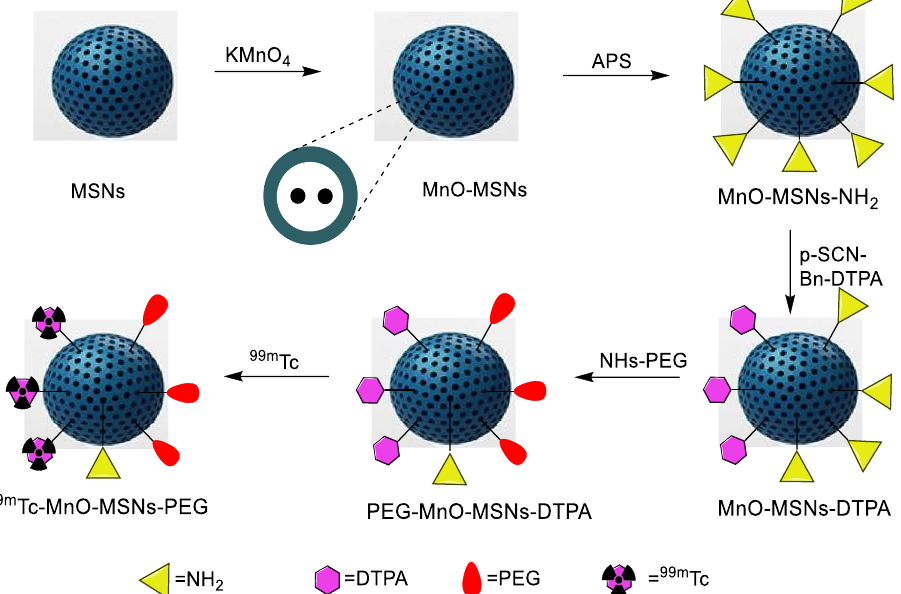
Figure 9. Synthesis of multifunctional mesoporous silica nanoparticles (SBA-15). Step 1: installation of APTMEES at room temperature, Step 2: conjugation of eosin isothiocyanate (EOITC) fluorescent dye, Step 3: conjugation of 99m Tc/ 188 Re chelator, Step 4: radiolabeling with 99m Tc or 188 Re [55].